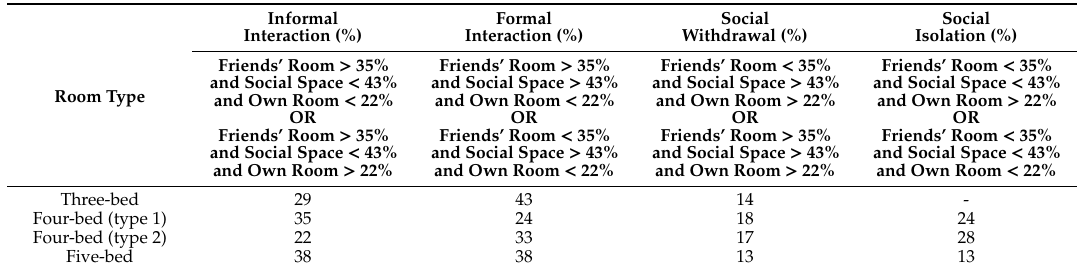
Table 6. Number of people engaged in a specific social behaviour in di ff erent